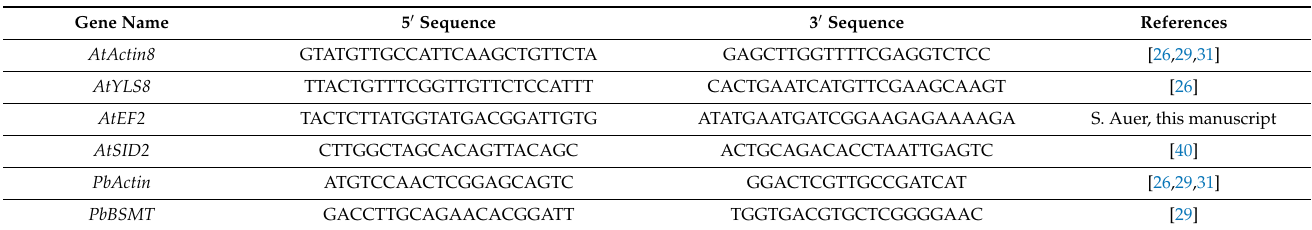
Table 1. Primer sequences used for qPCR in this